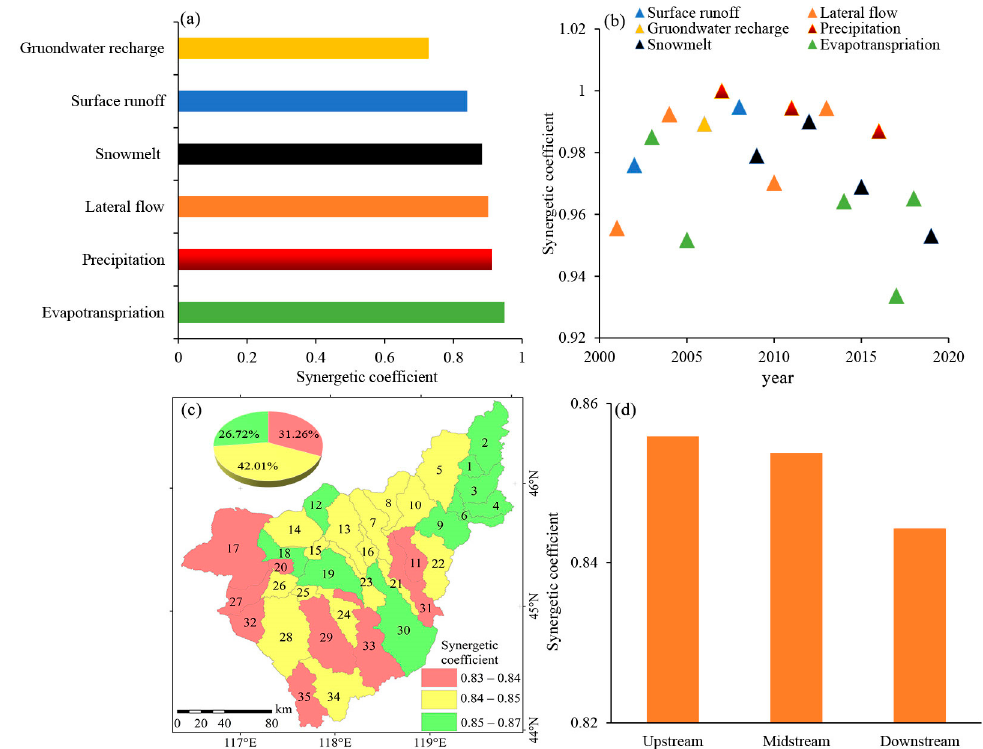
Figure 8. Synergy of hydrological process factors and EQ in URB ( a ), the most synergistic hydrolog- ical process factors ( b ), spatial distribution of average synergy between hydrological process factors and EQ in subbasins ( c ), and synergy between hydrological process factors and EQ system in different river sections ( d ).